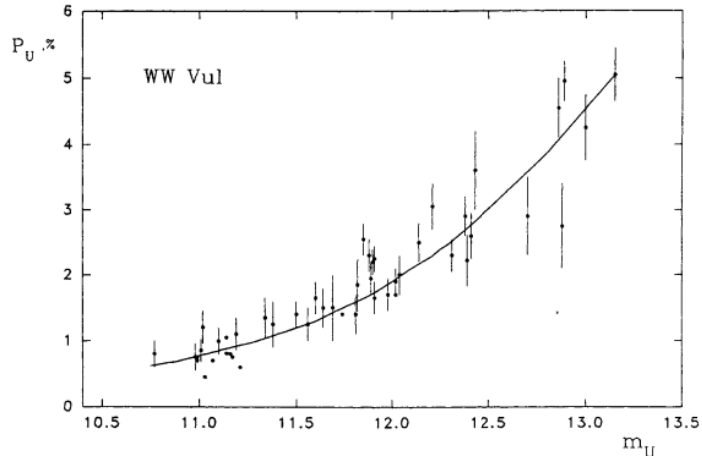
Figure 2. Dependence of the linear polarization degree on the brightness of the UX Ori type star WW Vul in the U band from [14]. Lines show theoretical dependencies calculated using Equations (2) and